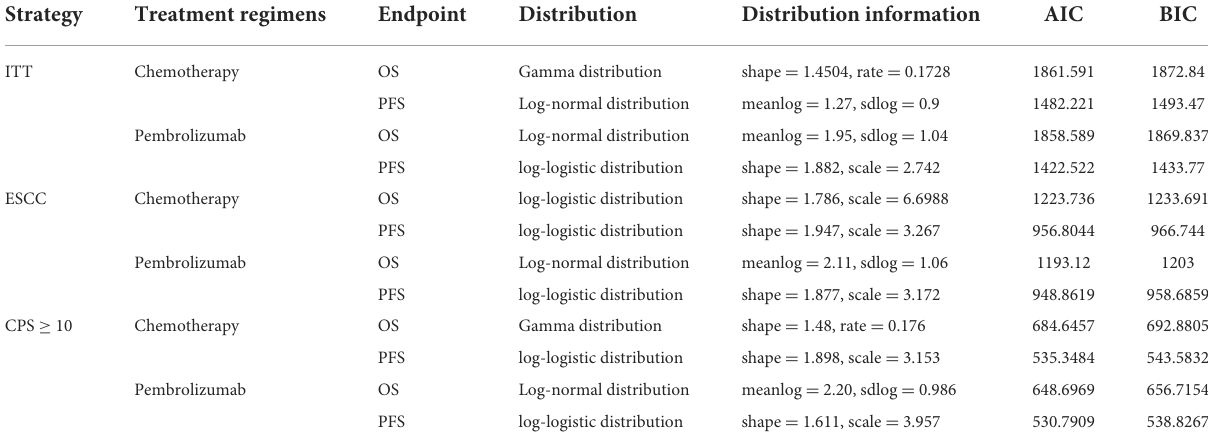
TABLE 1 Parameters of selected models.